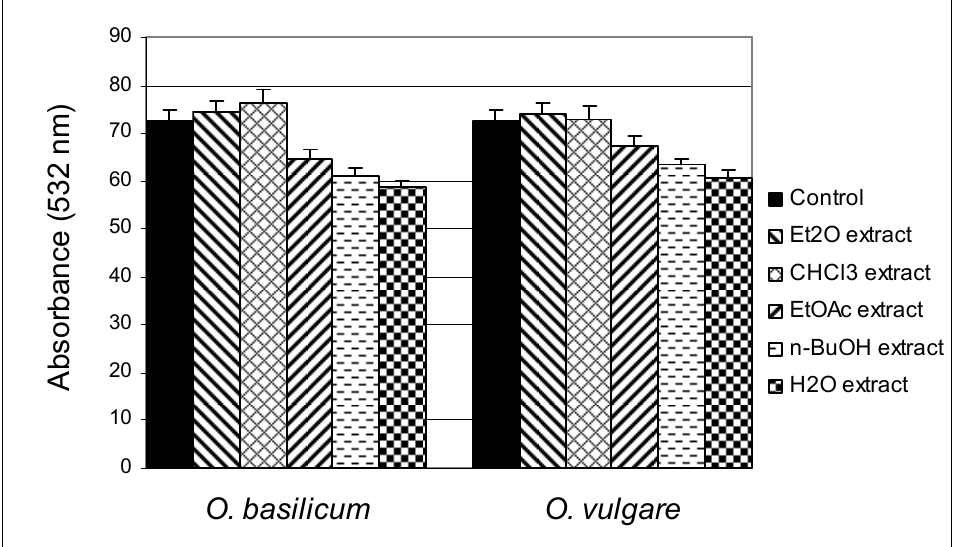
Figure 1. Inhibition of degradation of 2-deoxyribose by different extracts of O. basilicum and O. vulgare in the deoxyribose